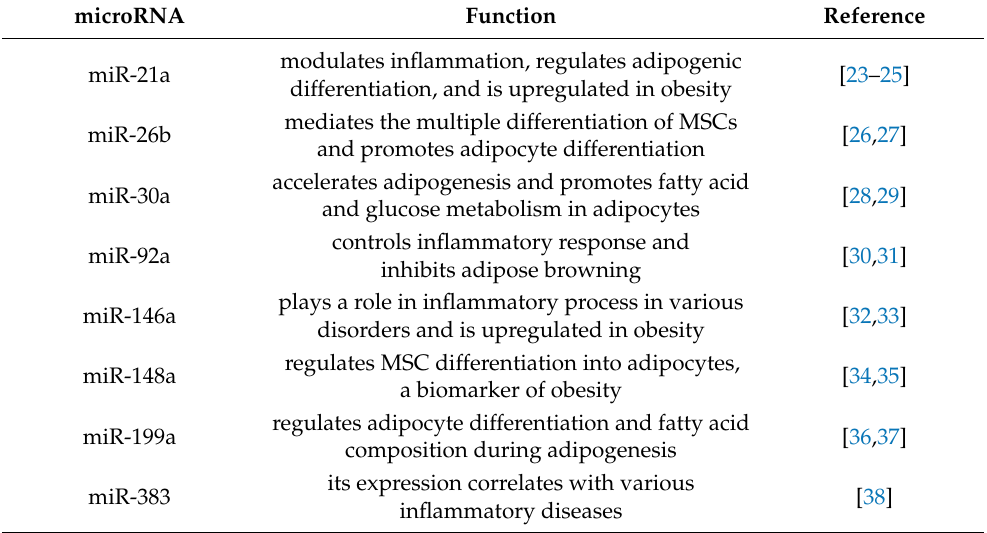
Table 1. Characteristics of the analyzed